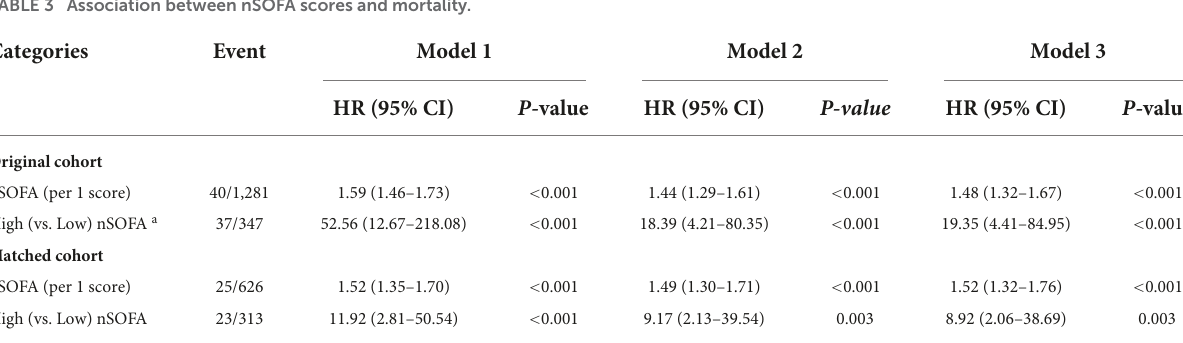
TABLE 3 Association between nSOFA scores and